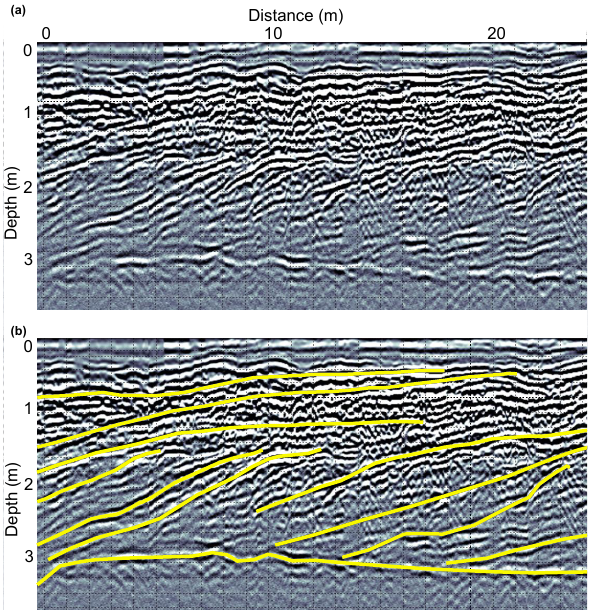
Figure 5. Example of a ground-penetrating radar (GPR) profile (250Hz) in the Prathoek bend. (a) Original GPR profile and (b) in- terpreted GPR profile with lateral accretion surfaces and the channel lag, indicated by yellow lines.